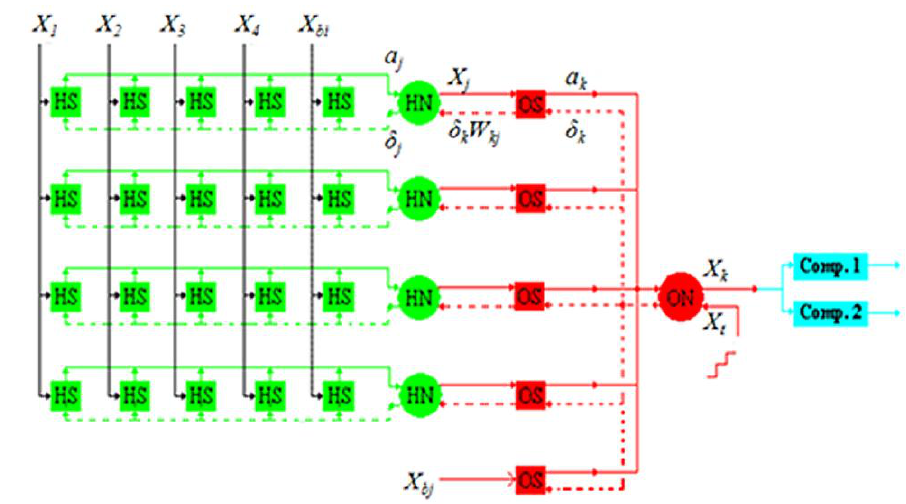
Figure 1. Block diagram of the proposed 4-4-1